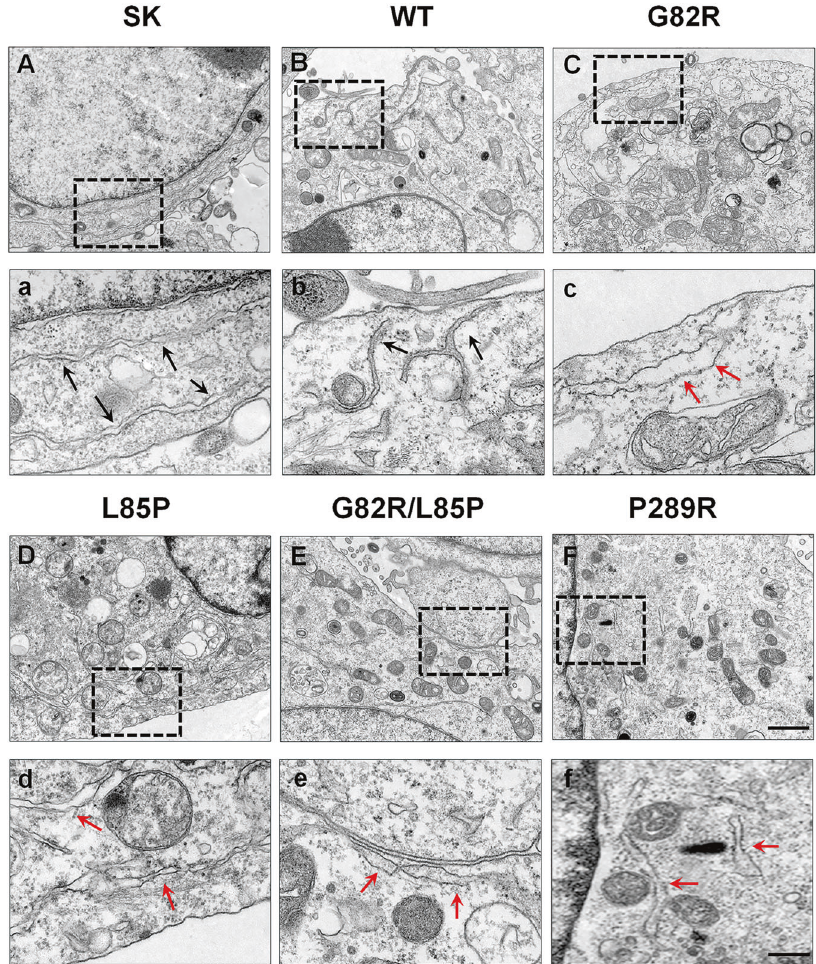
Fig. 5 Disease-related variants altered the morphology of the endoplasmic reticulum (ER). After transfection with different plasmids (SK, WT, G82R, L85P, G82R/L85P, and P289R) in HeLa cells, the morphology of ER was observed using TEM ( A – F ). The epileptic variants induced ER swelling (as indicated by the red arrows in ( C – F ). Scale bar, 1 μ m. Magni fi ed images are shown in the column of ( a – f ). Scale bar, 200